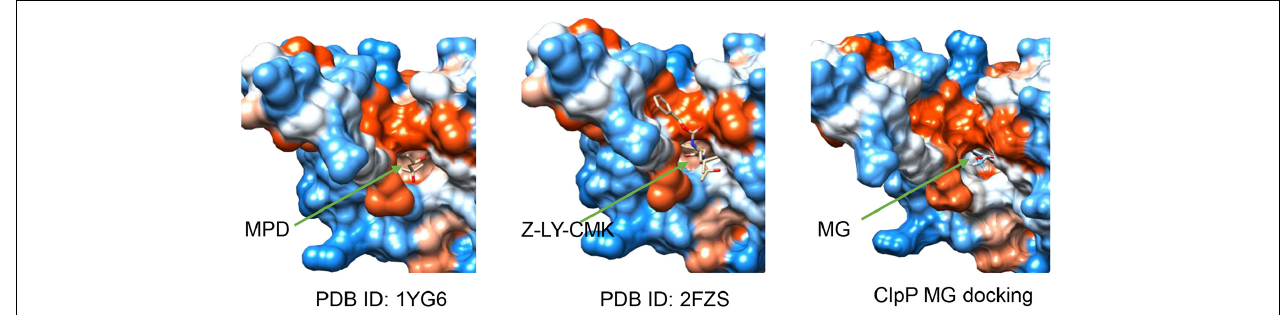
FIGURE 5 | Structures of ClpP binding with (4S)-2-methylpentane-2,4-diol (MPD) (PDB ID: 1YG6), benzyloxycarbonyl-leucyltyrosine chloromethyl ketone (Z-LY-CMK) (PDB ID: 2FZS), and methyl gallate (MG) (the best docking pose). Ligands were indicated by green arrows.